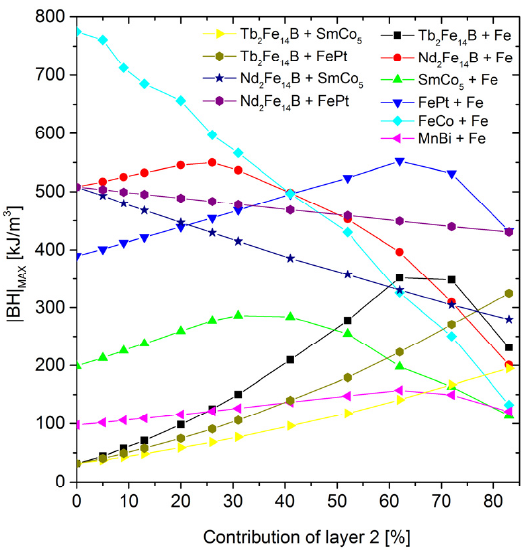
Figure 10. The | BH | max parameter as a function of the “layer 2” content.